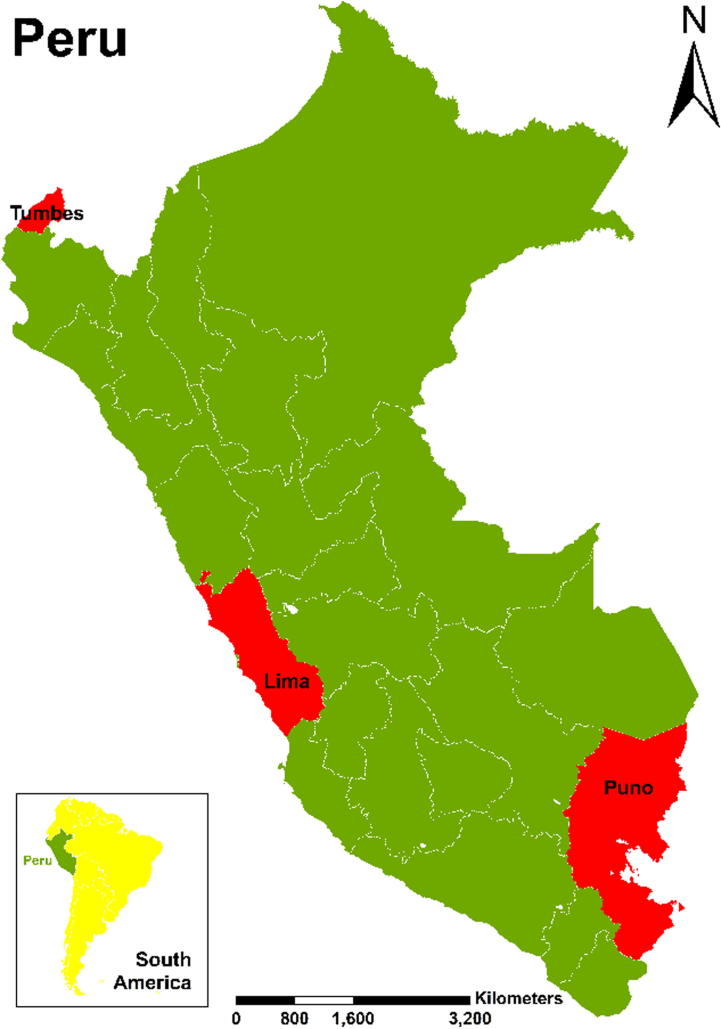
Map of Peru indicating the CRONICAS Cohort Study’s sites.